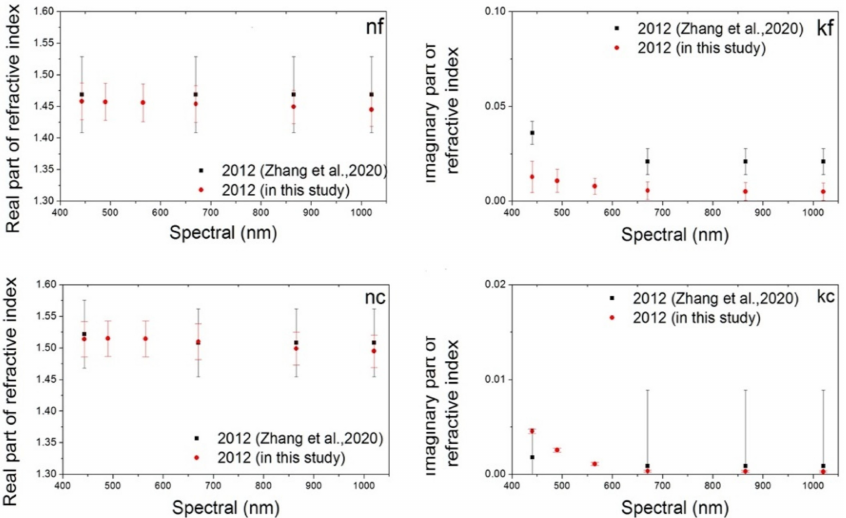
Figure 8. Comparison complex refractive index derived by Zhang et al. [17] for January 2012 in Beijing and the values retrieved in present study from POLDER-3/PARASOL satellite observations. Adapted with permission from ref. [17], Copyright 2020 Atmospheric Chemistry and